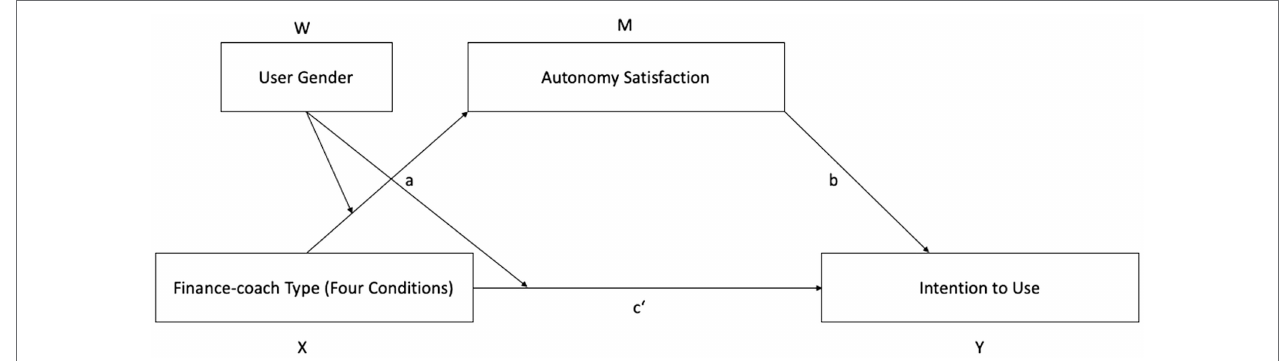
FIGURE 4 | Simple moderated mediation model (Model 8 in the Process macro by Hayes,